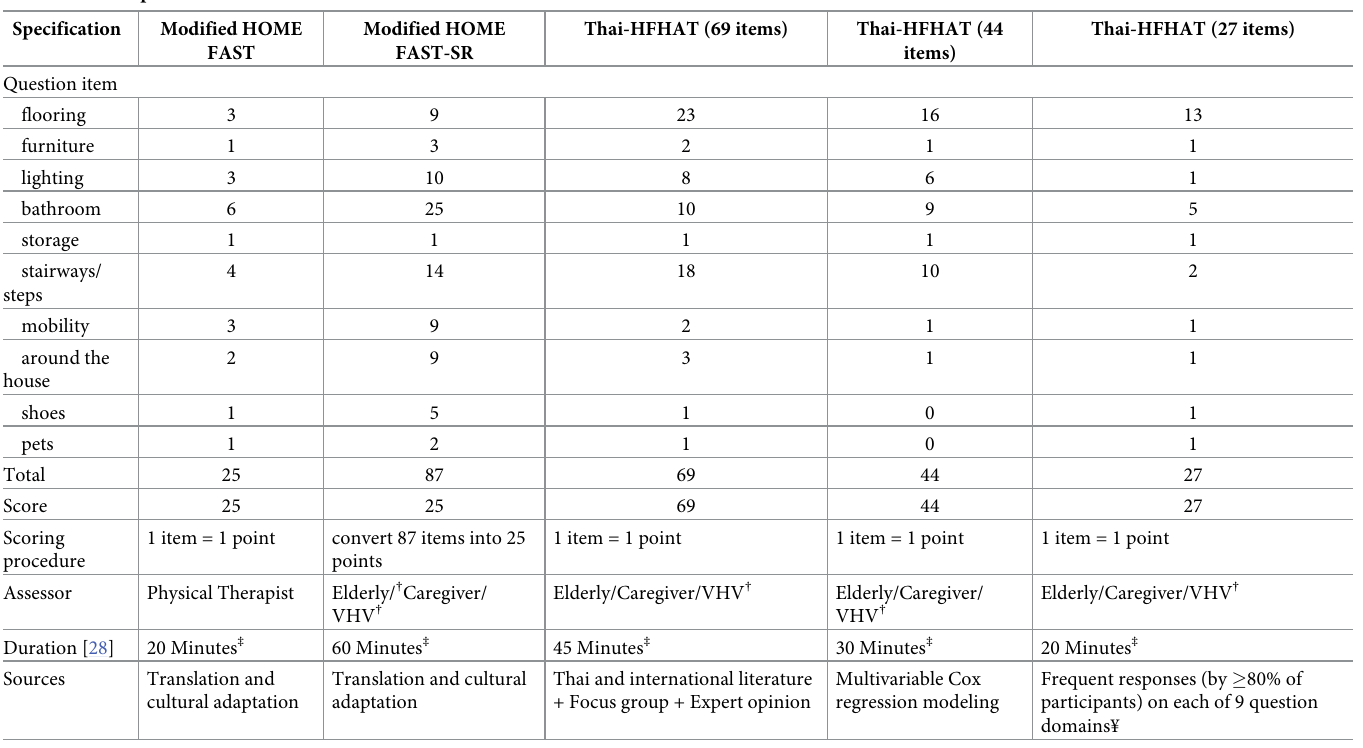
Table 1. Detail specification of home fall hazard assessment